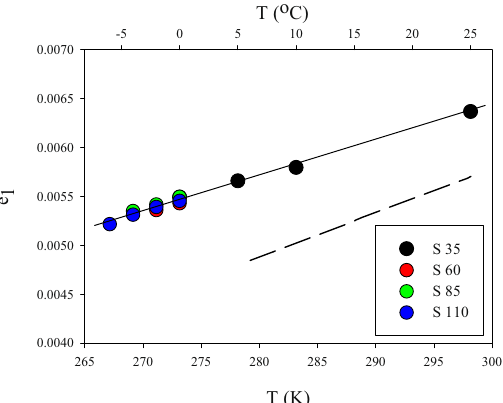
Figure 3. Values of e 1 as a function of temperature, obtained in NaCl solutions buffered with CH 3 COONa (pH ~4.5) with ionic strengths equivalent to salinities of 35, 60, 85 and 110. The dashed line represents the e 1 relationship determined by Liu et al . 31